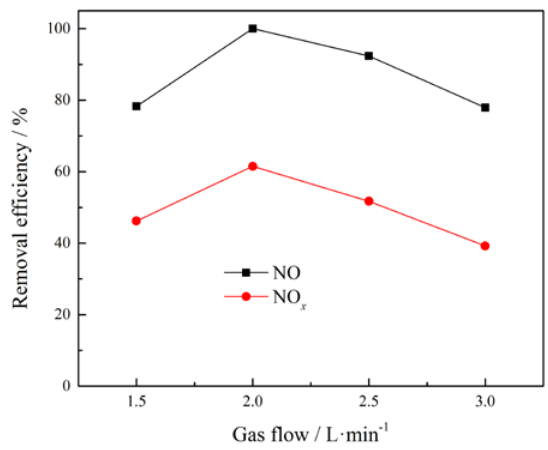
Figure 4. Effect of gas flow on the NOx removal efficiencies.